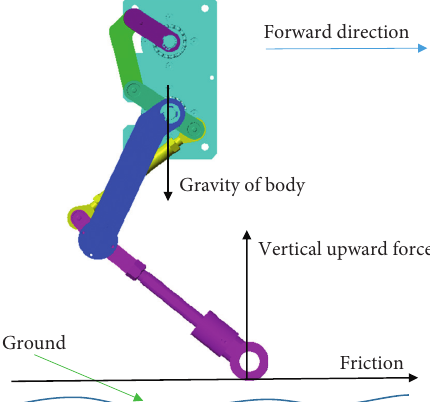
Figure 16: Reaction forces of the leg